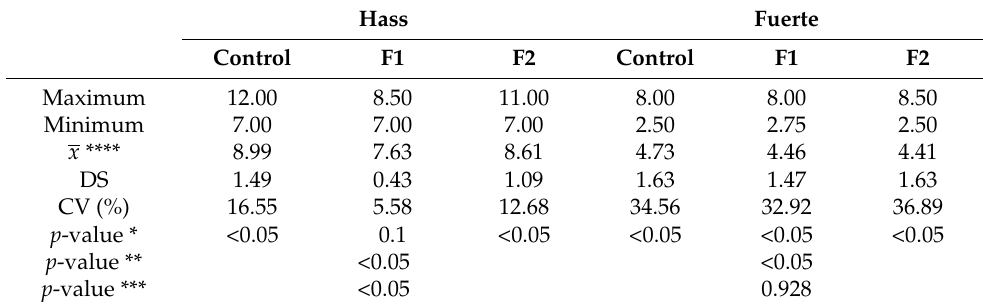
Table 5. Soluble solids ( ◦ Brix) of control and coated avocado.